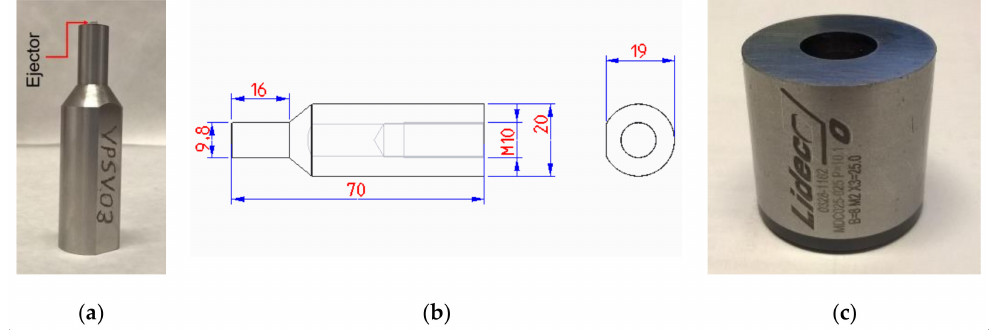
Figure 4. Images of the representative test punches and dies: ( a ) punch, ( b ) drawing of the tested punches, and ( c )